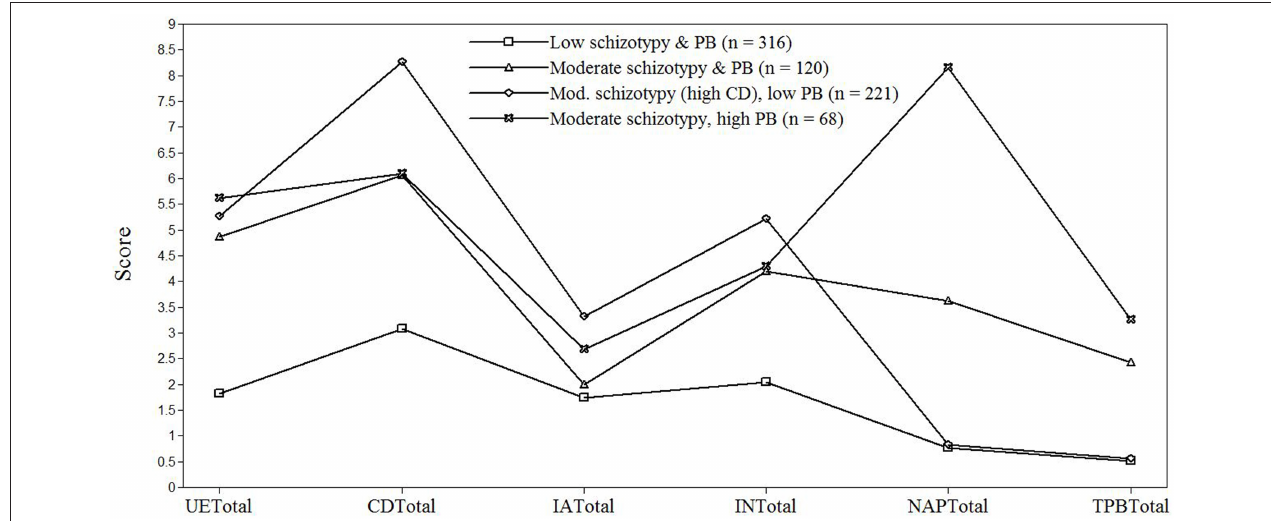
FIGURE 1 | Pattern of mean scores on the Oxford-Liverpool Inventory of Feelings and Experiences (O-Life) and the Revised Paranormal Belief Scale (RPBS) as a function of latent class. PB, Paranormal Belief; UETotal, Unusual Experiences-Total; CDTotal, Cognitive Disorganization-Total; IATotal, Introverted Anhedonia-Total; INTotal, Impulsive Non-conformity-Total; NAPTotal, New Age Philosophy-Total; TPBTotal, Traditional Paranormal Belief-Total.